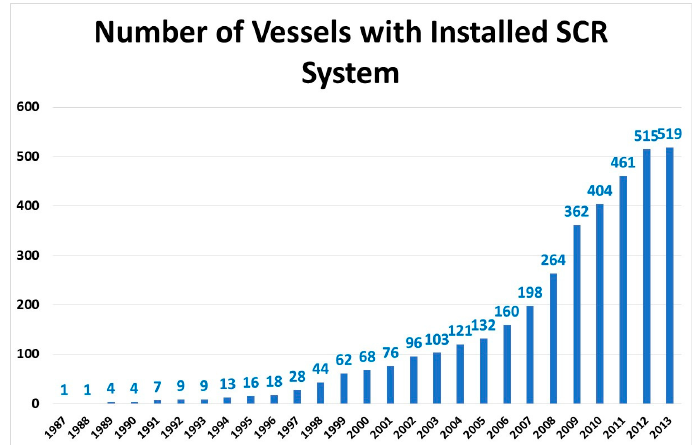
Figure 8. Number of vessels with installed SCR system from 1987 to 2013 (Figure was genuinely generated using numerical data from ref. [60]).